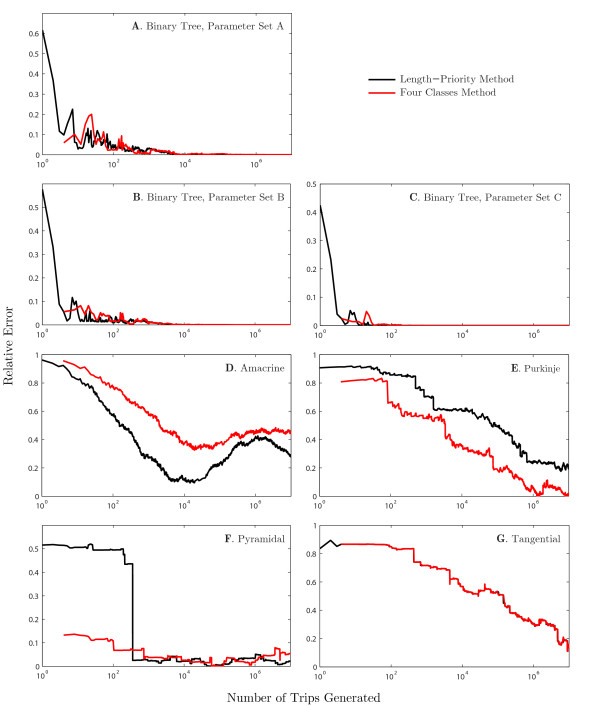
Convergence of the four-classes and length-priority methods for a number of dendritic morphologies. The relative error ε of the approximation of Gij(x,y,t) is shown as a function of the number of trips in the sum-over-trips framework for injection at y and measurement at x on the dendritic trees in Fig. 4. Membrane parameters for real dendritic morphologies: C=1 μF cm−2, R=3,000Ω cm2 and Ra=100Ω cm. Note that the four-classes method always begins with four trips, and each step in the algorithm adds a further trip of each class